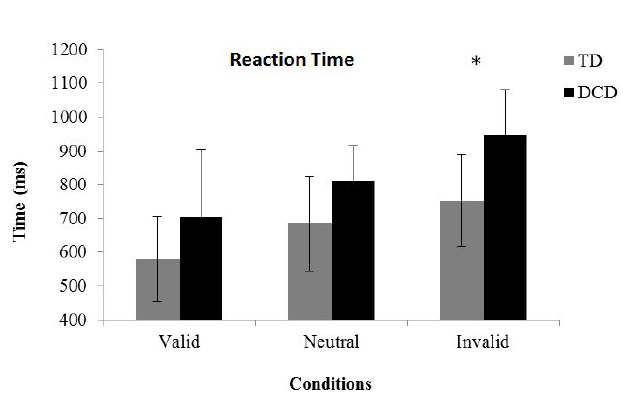
Figure 2. Reaction time (ms) of children with developmental coordi- nation disorder (DCD) and TD children under the valid, neutral, and invalid pre-cue information conditions.